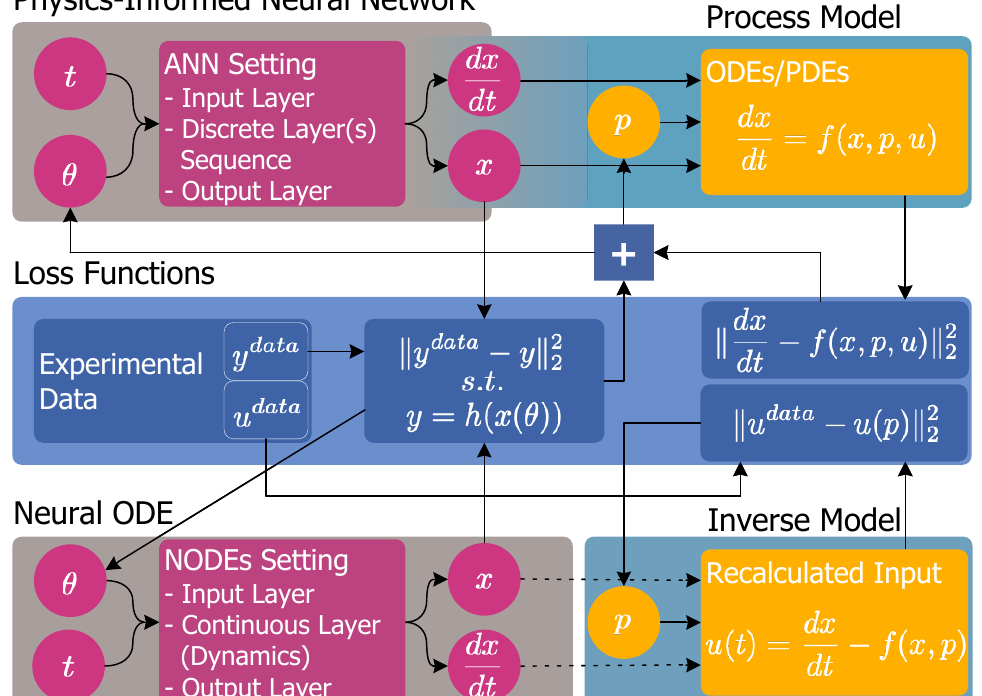
Figure 3. Comparative scheme of the physics-informed neural network (PINN) approach with the proposed procedure combining neural ordinary differential equations (NODEs) and the inverse model (recalculated model input via differential flatness), including needed loss function definitions and the use of experimental data to identify unknown model parameters p and hyperparameters θ of the two different neural network